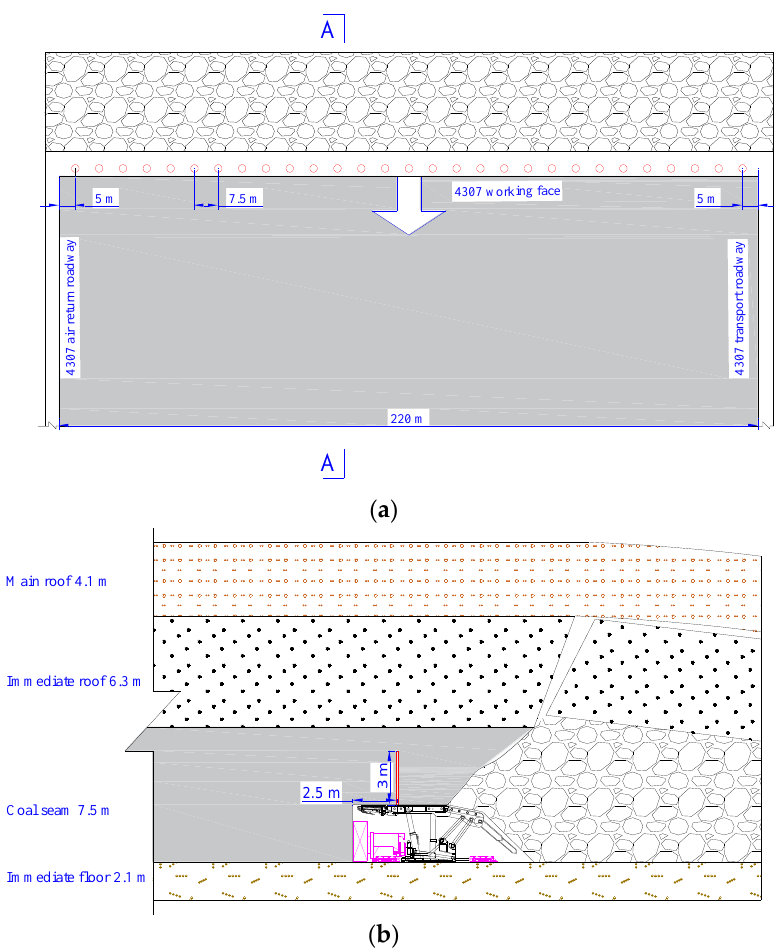
Figure 15. Blasting borehole layout of 4307 fully mechanized caving face in Bailu Coal Mine: ( a ) plan view and ( b ) A-A sectional view.